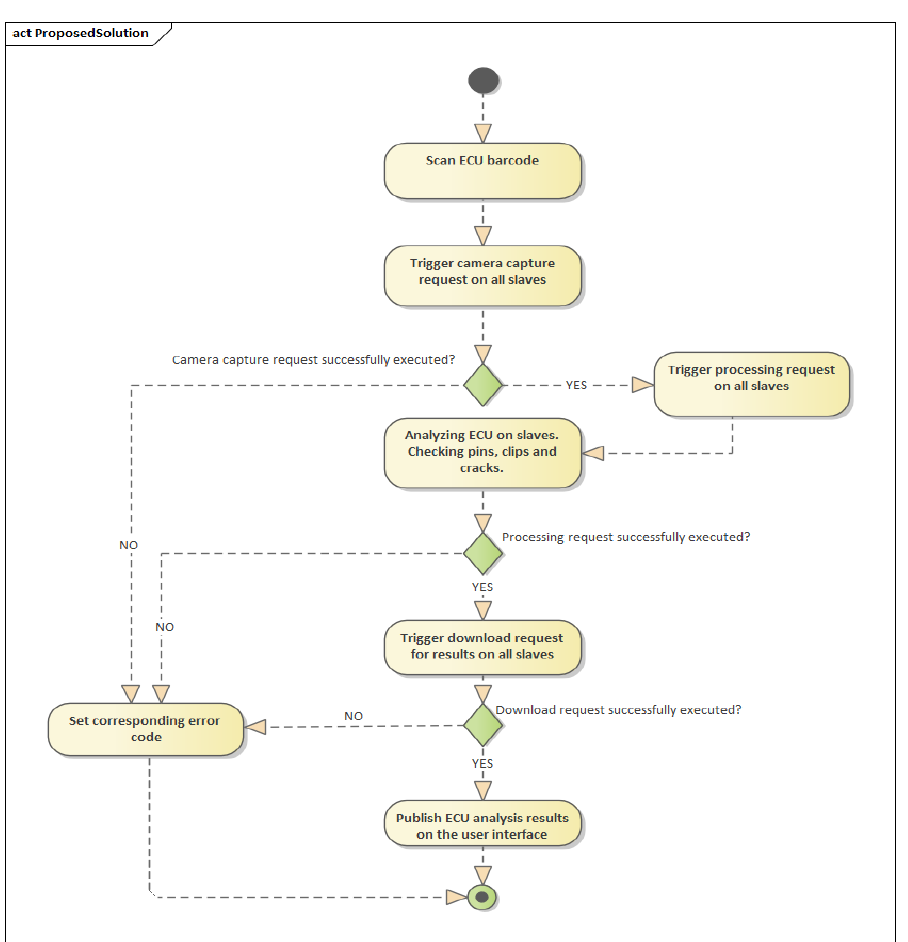
Figure 1. The abstract structure of informational flux in the image-processing-based low-cost fault detection experimental equipment.